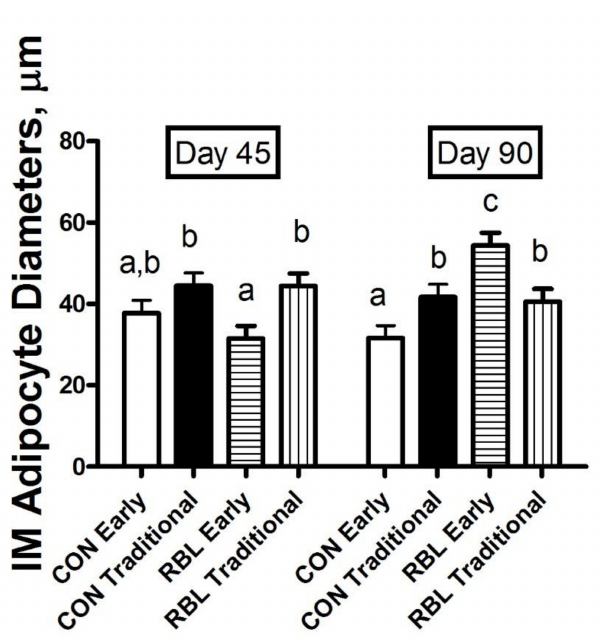
Figure 1. Intramuscualar (IM) adipocyte diameters ( µ m) of steers individually supplemented an isocaloric, isonitrogenous diet with no rumen by-pass lipid (CON; n = 24) or with a rumen by-pass lipid (Essentiom ™ ; RBL; n = 24) daily and fed for a duration of either 45 or 90 d. Values are ± SEM. a, b, c: Means without common letters indicate significant di ff erences (weaning × treatment × day: p =